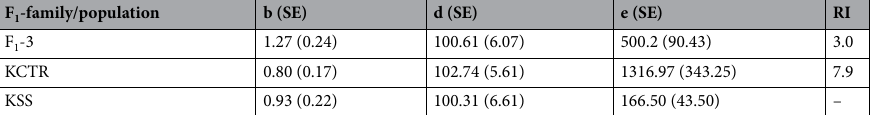
Table 3. Regression parameters describing the response of F 1 -3 progenies along with 2,4-D susceptible (KSS), resistant (KCTR) Palmer amaranth to 2, 4-D under growth chamber conditions (Eq.